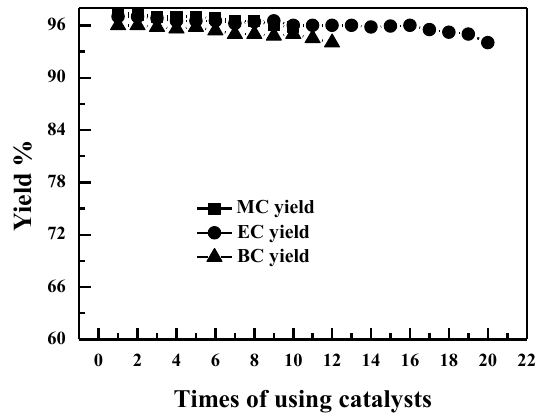
Figure 12. Reusability testing of catalysts 2.9 wt% TiO 2 /SiO 2 -500 for synthesis of MC, 7.1 wt% Cr 2 O 3 -6.3 wt% NiO/SiO 2 -500 for synthesis of EC and 1.4 wt% TiO 2 -6.1 wt% Cr 2 O 3 /SiO 2 -500 for synthesis of BC.